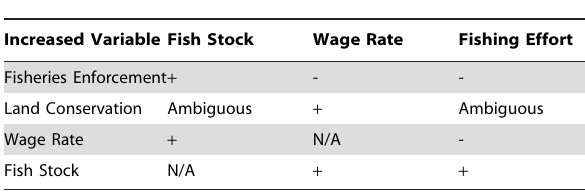
Table 1. Results from analytic